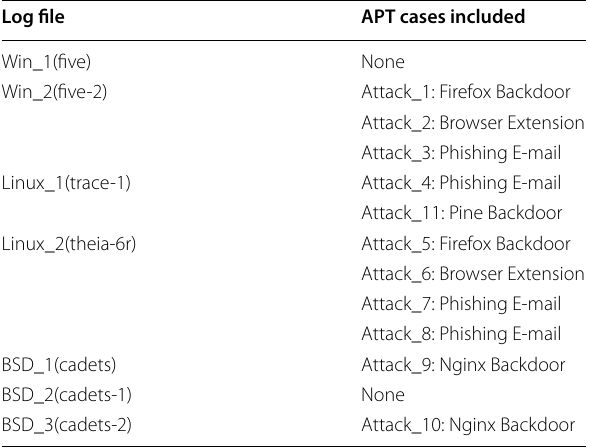
Table 1 APT cases of dataset